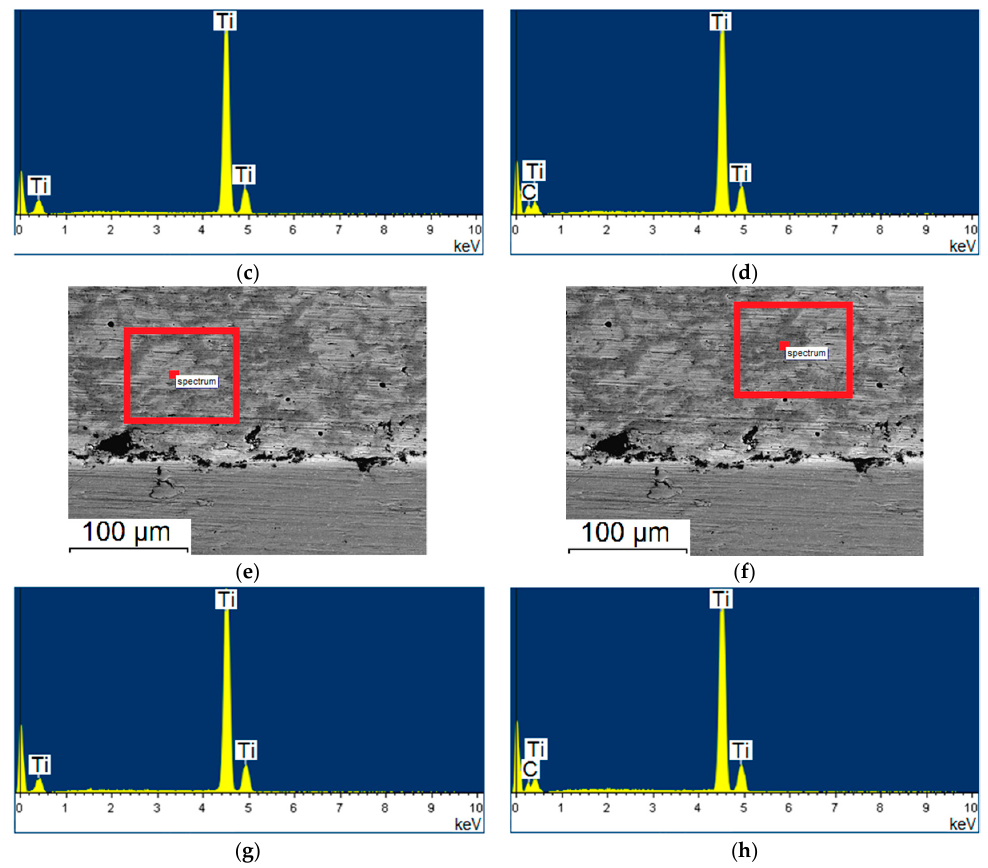
Figure 7. SEM-micrographs of the coating cross-section and EDS results: specimen produced in regime No. 5 ( a – d ) and No. 6 ( e – h ). A circle within red rectangle shows the location where EDS analysis was carried